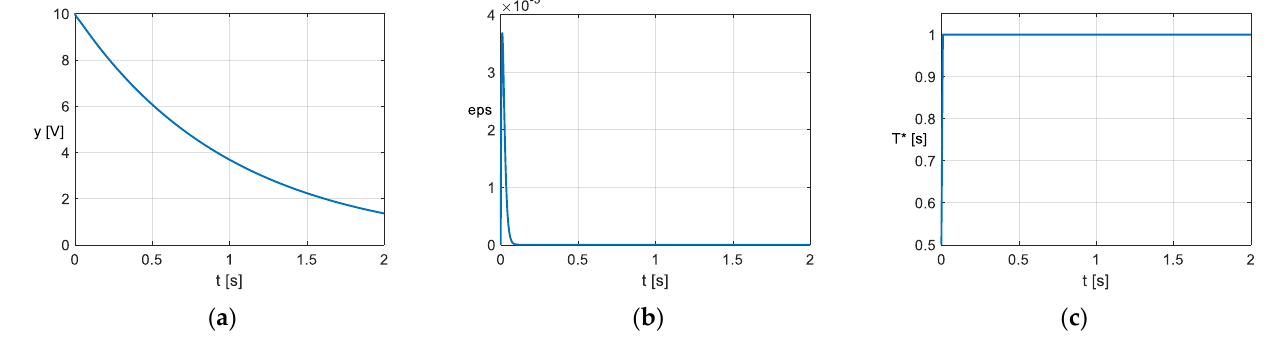
Figure 3. The behavior of the PO for y ( t ) = 10𝑒 −𝑡 , 𝑧̂ 𝑜 = 2.302585 , 𝑐̂ 𝑜 = −2 , 𝜏 = 0.5 s , 𝜔 𝑜 = 100 s −1 , K p = 200 s −1 , K i = 10,000 s −2 : ( a ) input signal y ( t ); ( b ), error ( t ); ( c ) estimated time-constant.